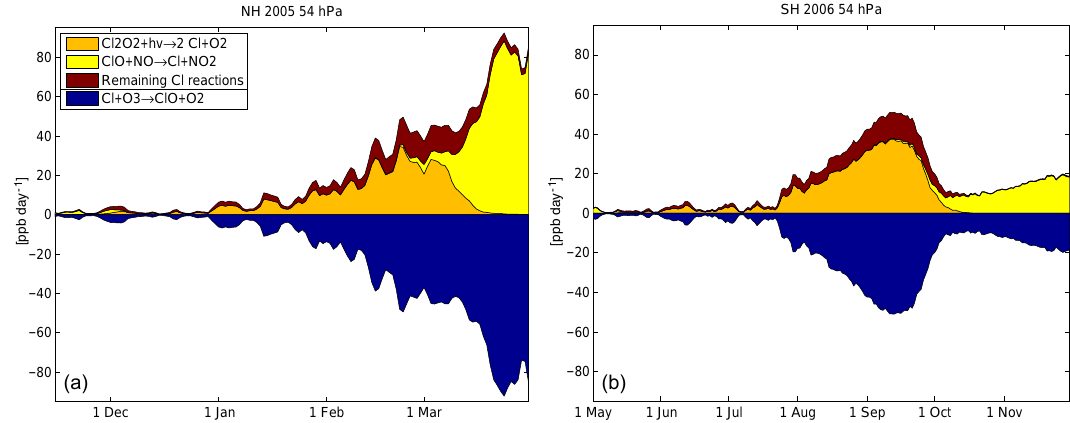
Figure 15. Vortex-averaged chemical reaction rates of reactions involving Cl for the Arctic winter 2004–2005 (a) and the Antarctic winter 2006 (b) at 54hPa. Production reactions are shown as positive and are separated by a line in the legend from the loss reactions, which are shown as